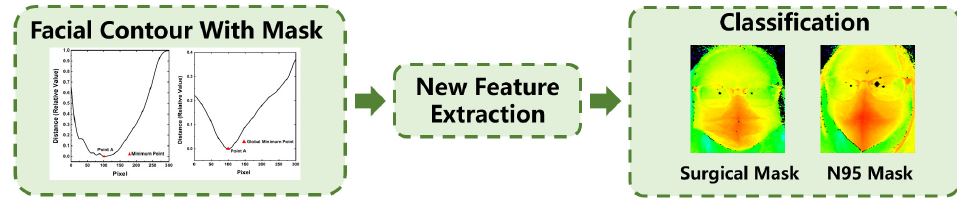
Figure 5. Identification process for mask types.